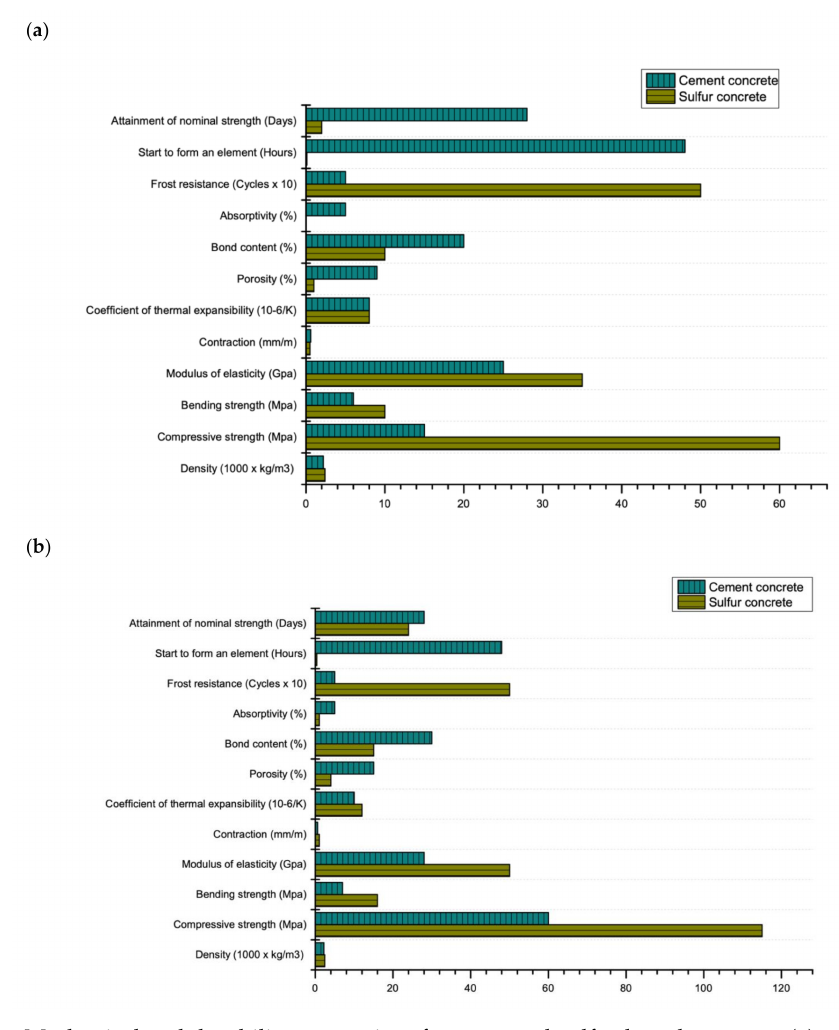
Figure 1. Mechanical and durability properties of cement and sulfur-based concrete: ( a ) maximum (grade M60) ( b ) minimum (grade M15) (data extracted from Reference